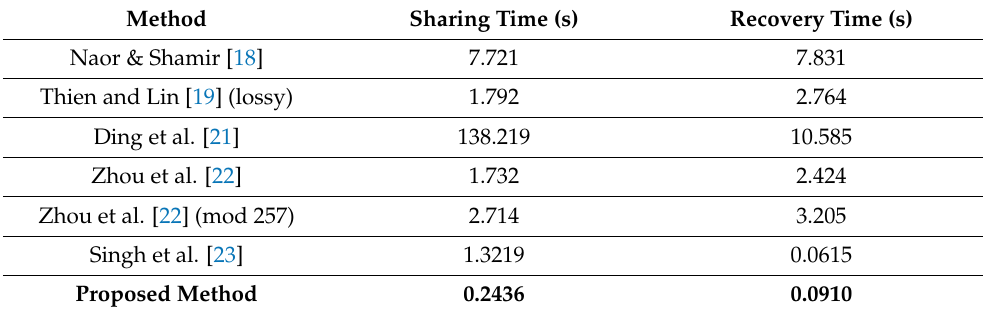
Table 4. Comparison of execution